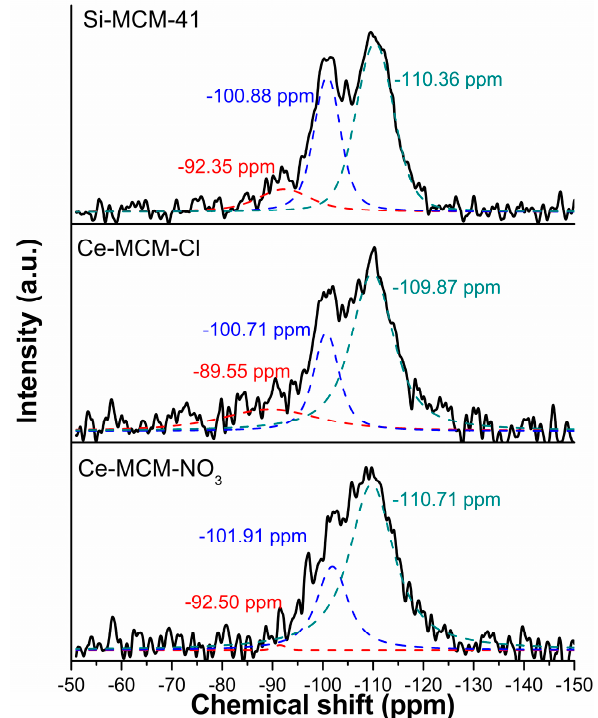
Figure 7. 29 Si MAS-NMR spectra for the calcined MCM-41 materials, highlighting the position of each chemical environment detected by deconvolution.